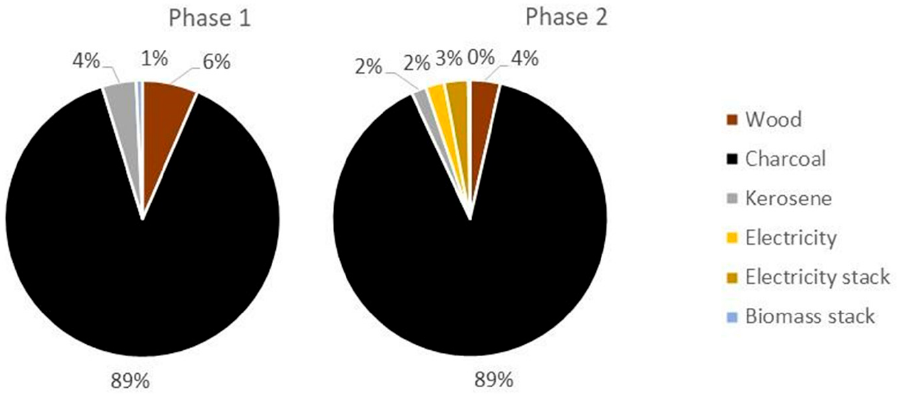
Figure 8. Mix of fuels used for heating events (Phase 1 and 2).